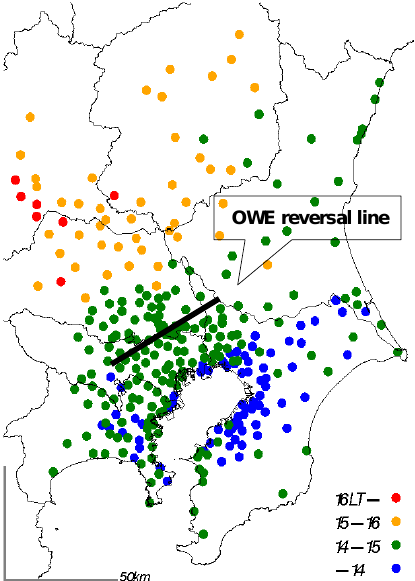
Fig. 12. Mean observed occurrence time of O 3max ( T max ) on 95– 100th percentile rank weekdays for TMA ozone levels during 1999– 2004. Features on Sundays are similar to those on weekdays. The OWE reversal line is estimated from Fig.